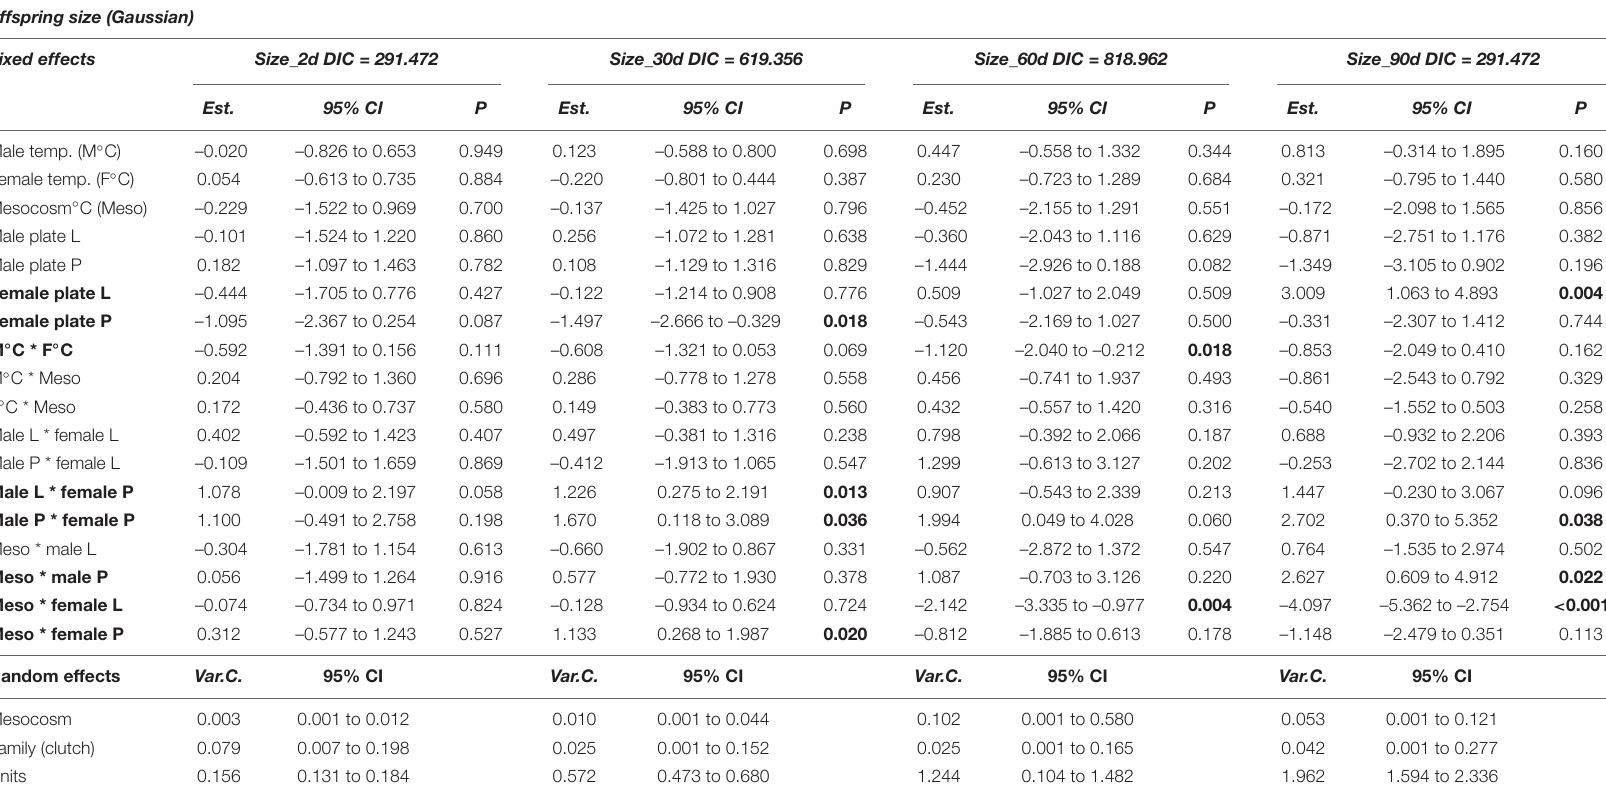
TABLE 3 | Offspring size (standard length: mm) over time (at 2 days to 90 days post-hatch) of stickleback ( Gasterosteus aculeatus ) depending on parental acclimation temperature (M ◦ C, F ◦ C), offspring environment (mesocosm) temperature, and parental plate morph (C, complete; L, low; P,